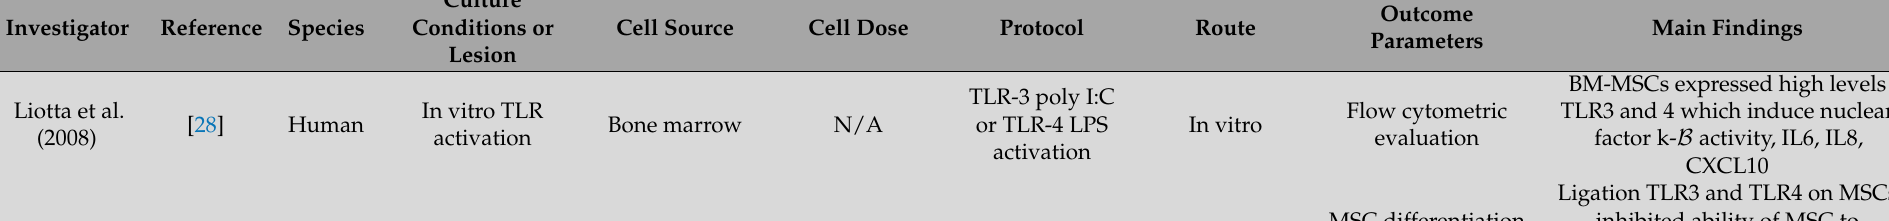
Table 2. Summary of studies demonstrating evidence that activation of MSC enhances their innate antibacterial and immunomodulatory